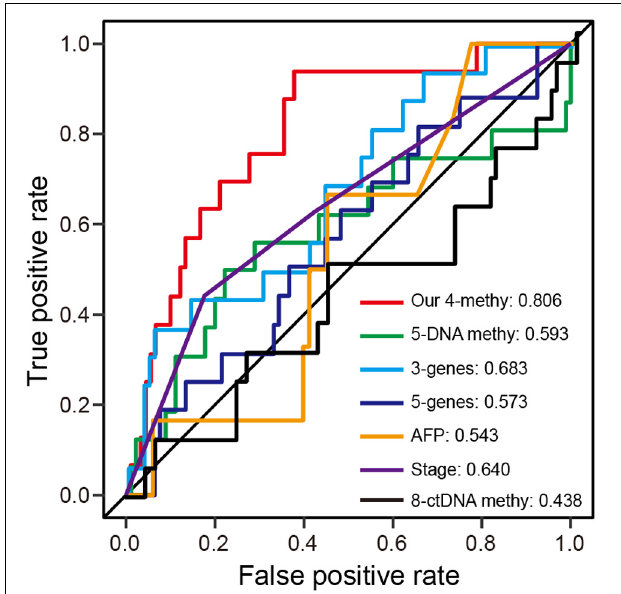
FIGURE 5 | ROC analysis of different prognostic biomarkers. (A) ROC curves demonstrate the sensitivity and specificity of the four-DNA methylation marker prognostic signature and other known prognostic biomarkers using the validation dataset (one-third of TCGA dataset).